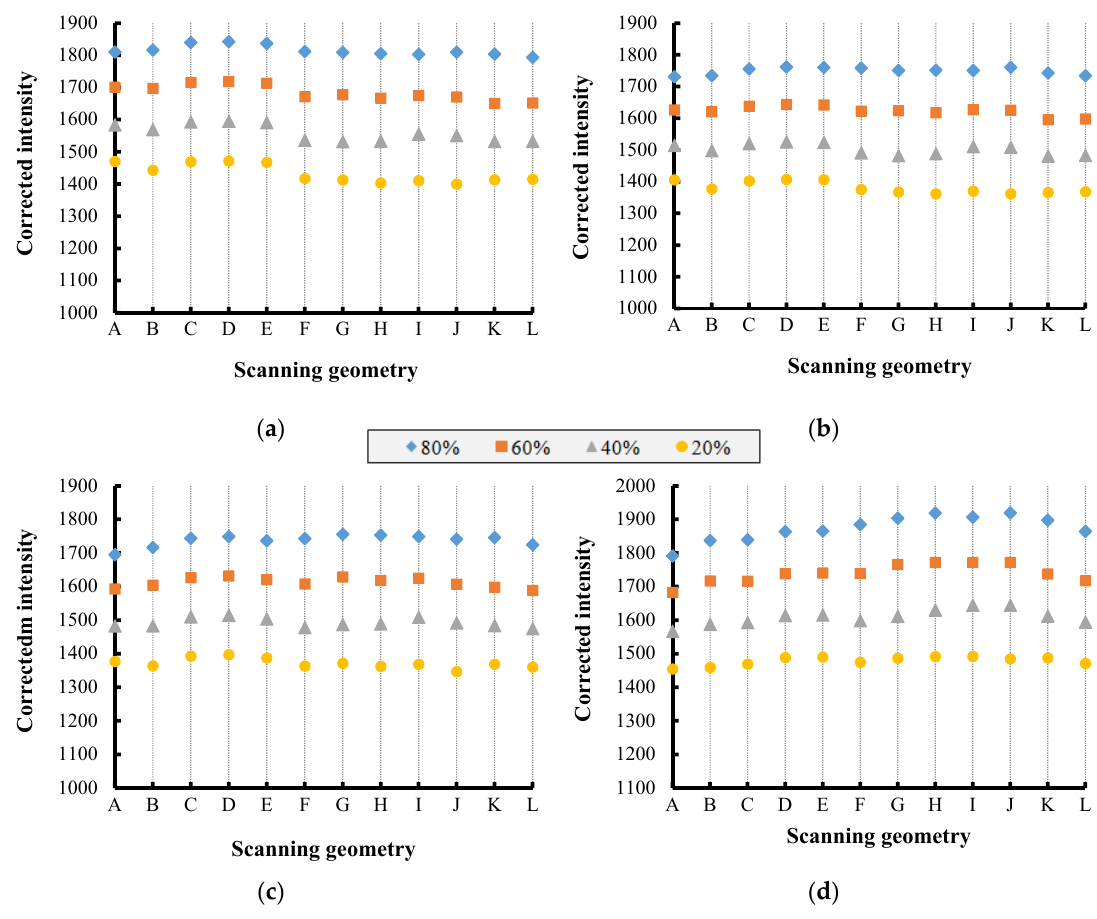
Figure 6. Relative correction results for the four targets at scanning geometries from A to L. ( a ) The 80% target is used as a reference; ( b ) The 60% target is used as a reference; ( c ) The 40% target is used as a reference; ( d ) The 20% target is used as a reference.